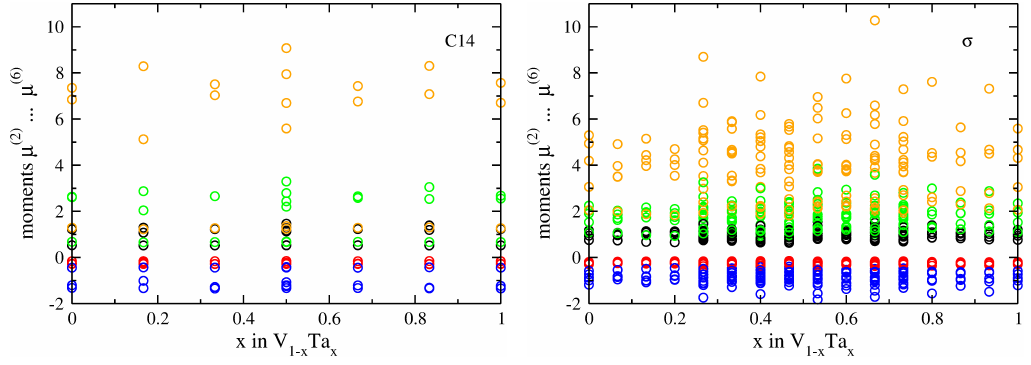
Figure 6. Variation of moments due to internal relaxation in the V-Ta compound system for the TCP phases C14 ( left ) and σ ( right ). The moments of the DFT-relaxed unit cells were scaled such that (cid:104) µ ( 2 ) (cid:105) = 1. (for color coding, see Figure 2.)